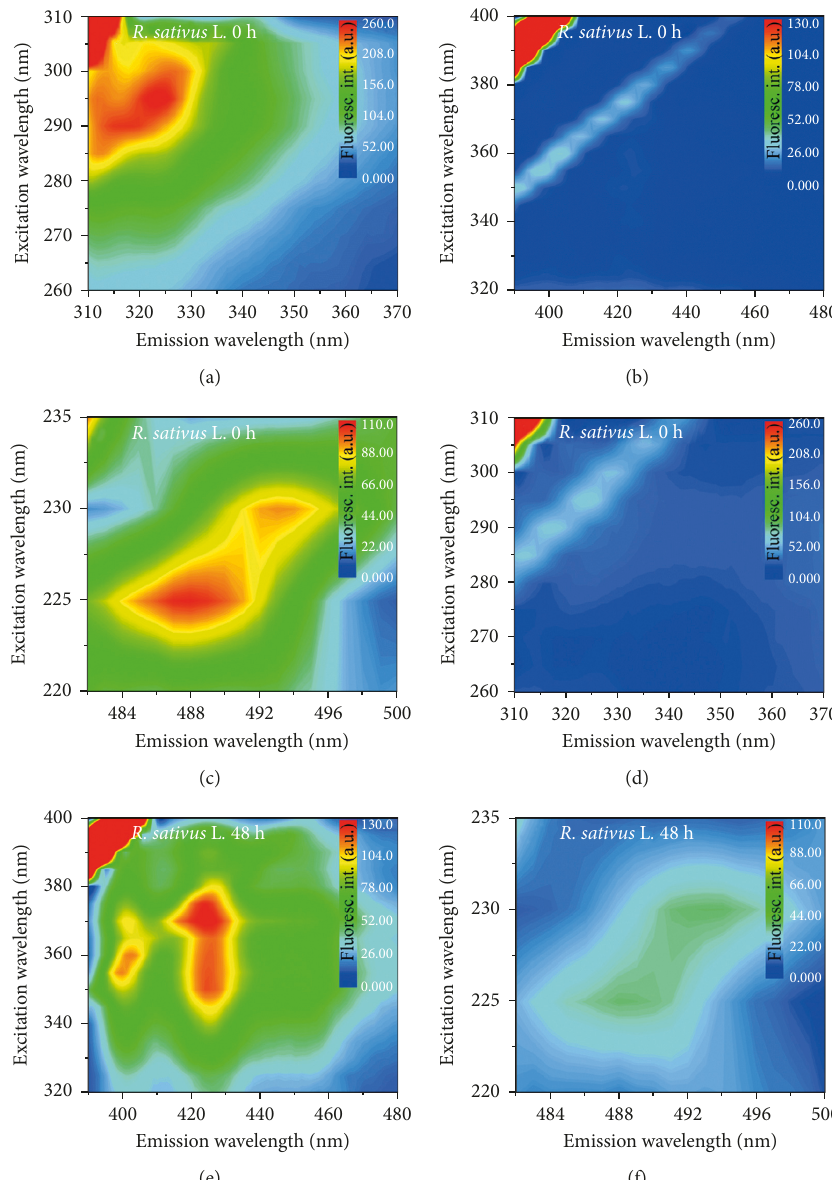
Figure 5: Fluorescence intensity maps of R. sativus L. biodiesel before the oxidative process and after 48h of degradation. Scattering not